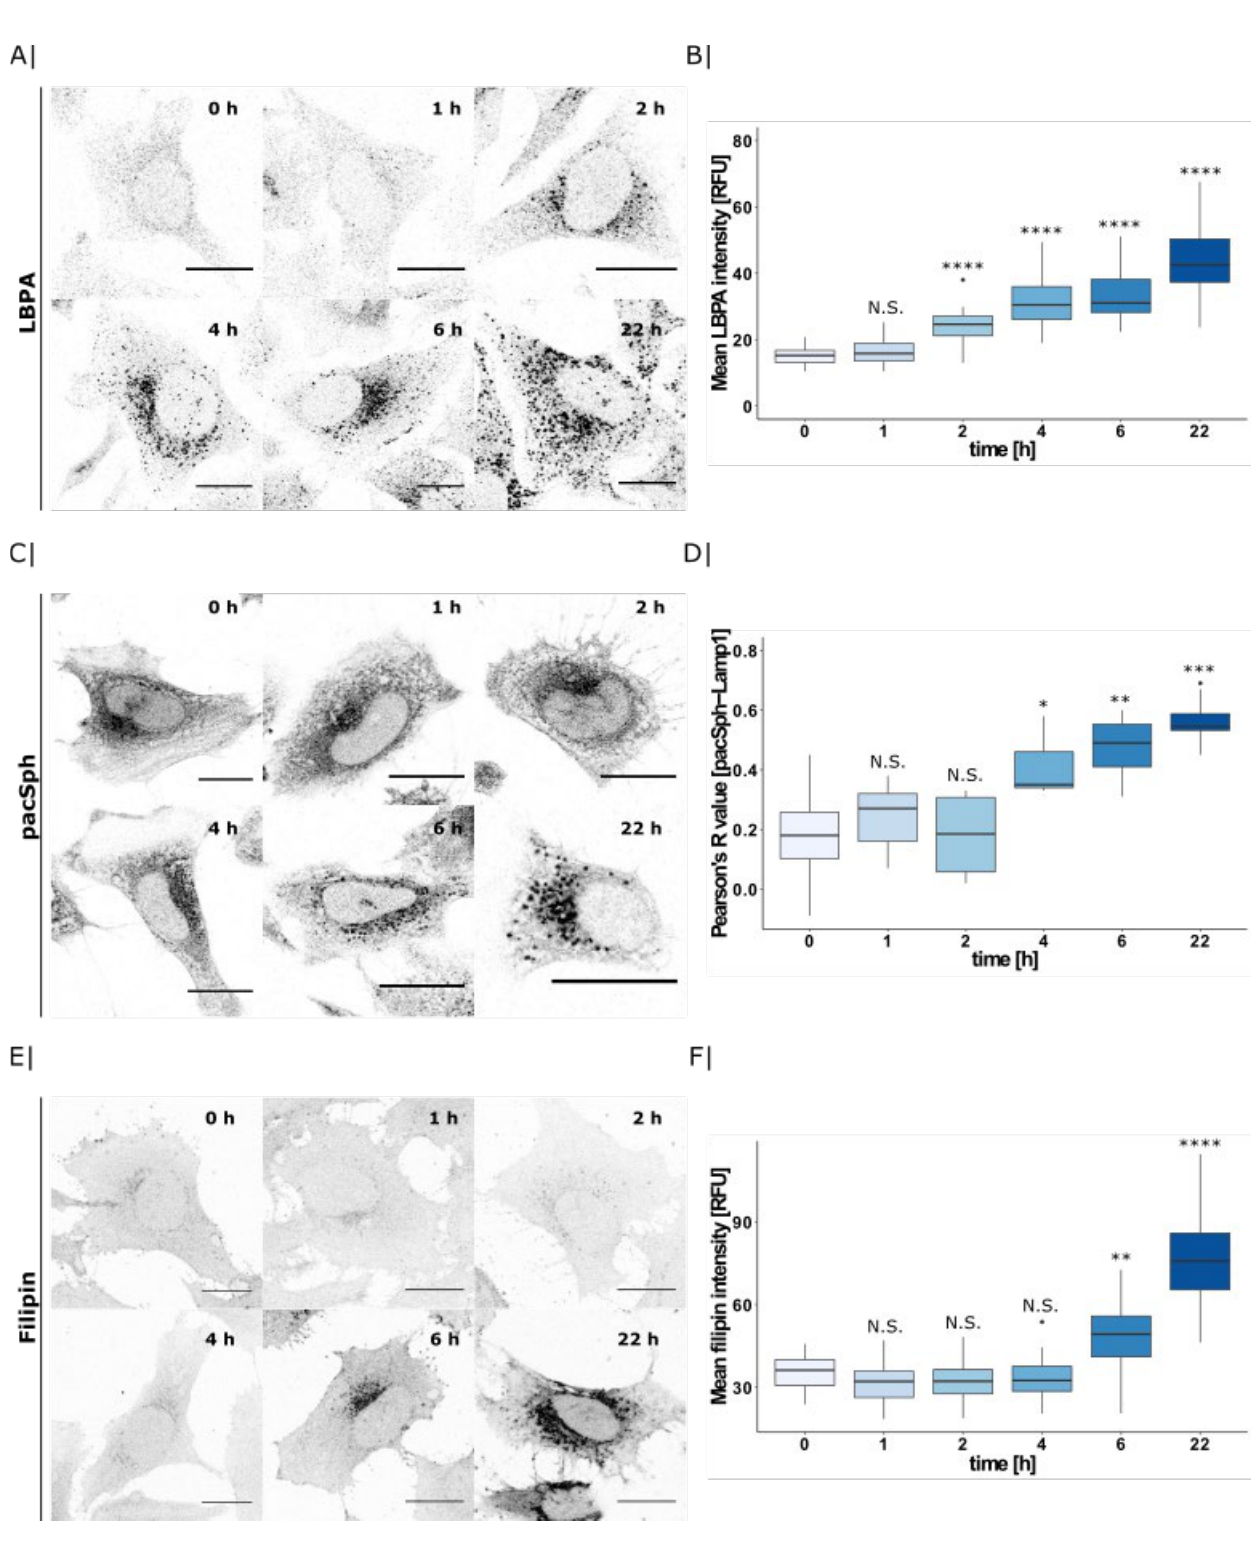
Figure 3. PDMP time-course and its effect on lysosomal lipid accumulation. ( A ) HeLa WT cells were treated with PDMP (20 µ M) for 0–22 h and LBPA was visualized by immunofluorescence using an LBPA-antibody. Scale bar indicates 20 µ m. ( B ) Mean LBPA intensity was calculated for each cell (0 h: n = 57 cells, 1 h: n = 44 cells, 2 h: n = 25 cells, 4 h: n = 36 cells, 6 h: n = 30 cells, and 22 h: n = 37 cells) and are presented as boxplots. Center lines show the median; box limits indicate first (Q1) and third quartiles (Q3); and whiskers extend to a maximum distance of 1.5*IQR (interquartile range) from Q1 and Q3, respectively, or to the most extreme datapoint within that range. Welch two sample t -tests were performed between 0 h timepoint and all other timepoints (1 h: N.S. p = 5.8 × 10 − 2 , 2 h: **** p = 6.9 × 10 − 9 , 4 h: **** p = 1.5 × 10 − 16 , 6 h: **** p = 3.0 × 10 − 15 , 22 h: **** p = 5.7 × 10 − 19 ). ( C )